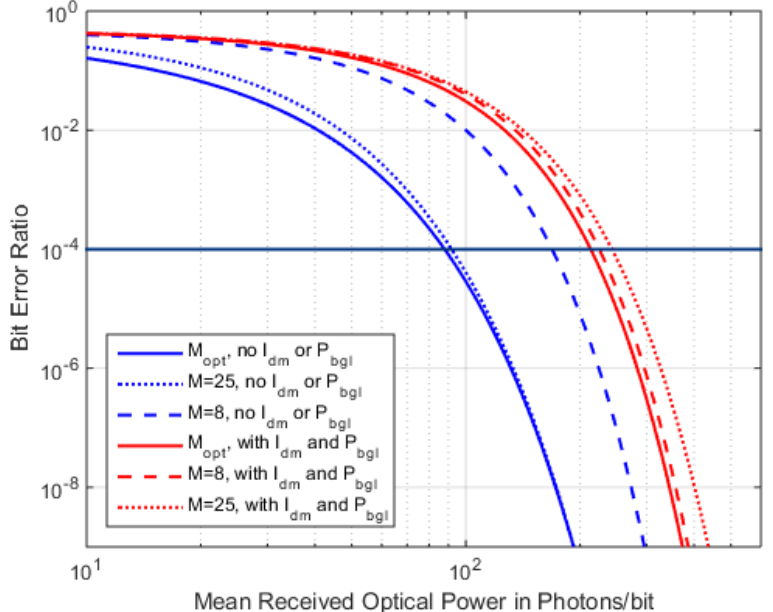
Figure 13. BER over <N> , with a fixed M = 8 and M = 25 compared with M opt adopted to P Rx , without and with P BGL = 50 nW and I dm = 2.5 nA.